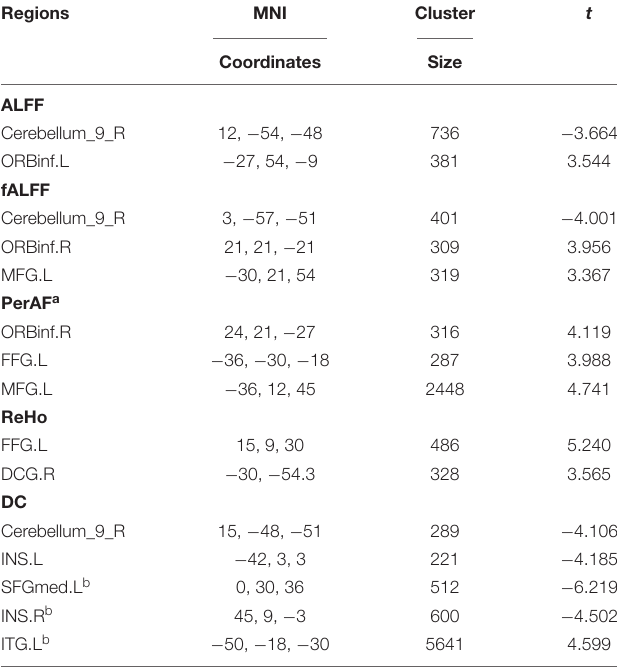
TABLE 2 | Differences in brain intrinsic activity between MCI reverters and